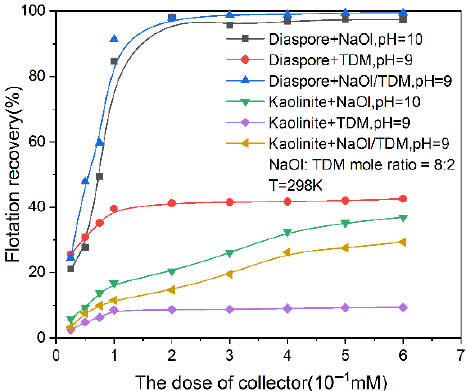
Figure 3. Effect of the collector dosage on the diaspore and kaolinite flotation recovery with NaOl (pH = 10), TDM (pH = 9) or NaOl/TDM (pH = 9, NaOl:TDM mole ratio = 8:2) as collectors at 298 K.